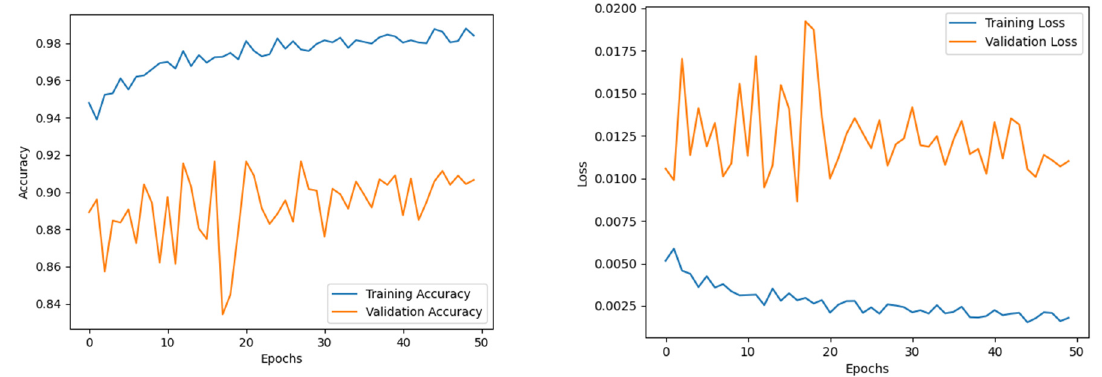
Figure 5. Accuracy and loss of EfficientNet B0.